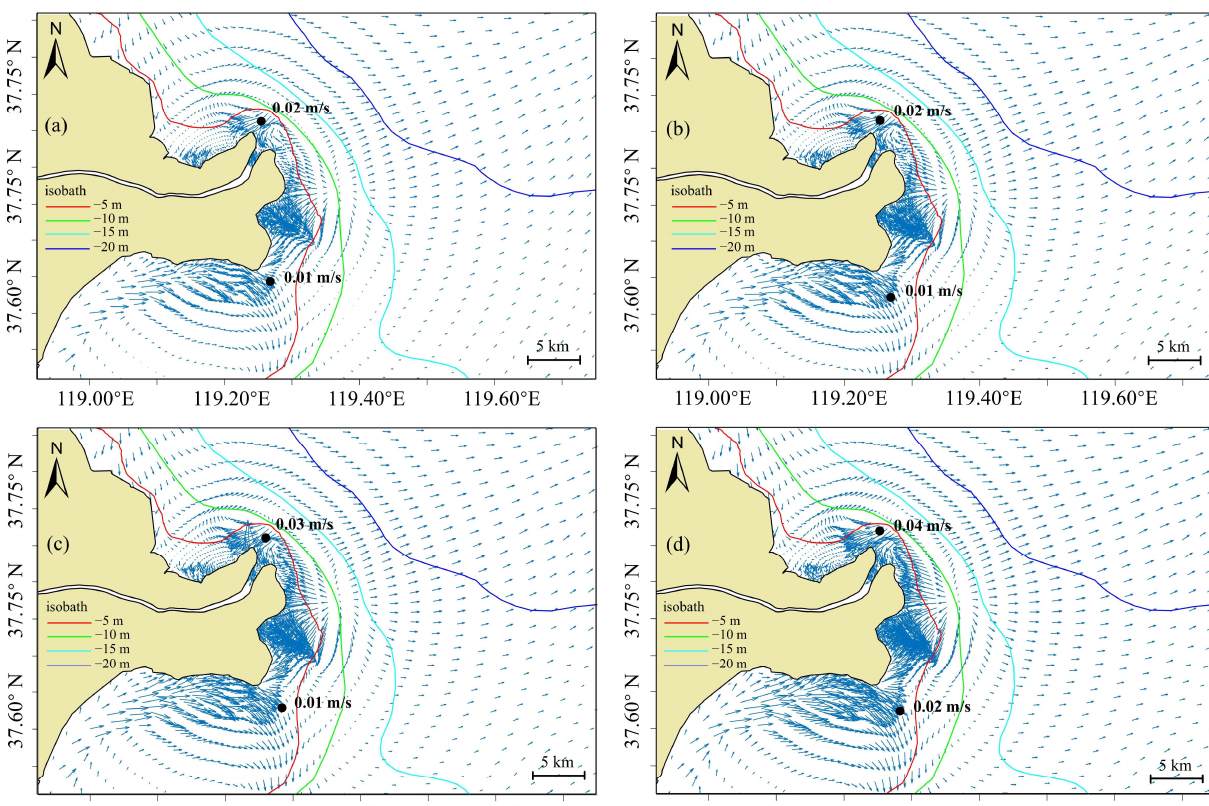
Figure 11. Residual current of the four runoff scenarios during spring tide: ( a ) Q 500 , ( b ) Q 1500 , ( c ) Q 4000 , and ( d ) Q 7500 .